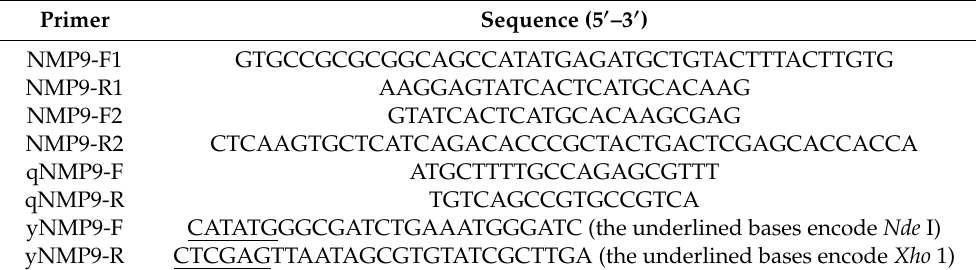
Table 1. Primers were used for cloning and expressing the NtMMP-9 gene in this study. Primer Sequence (5 (cid:48) –3 (cid:48)